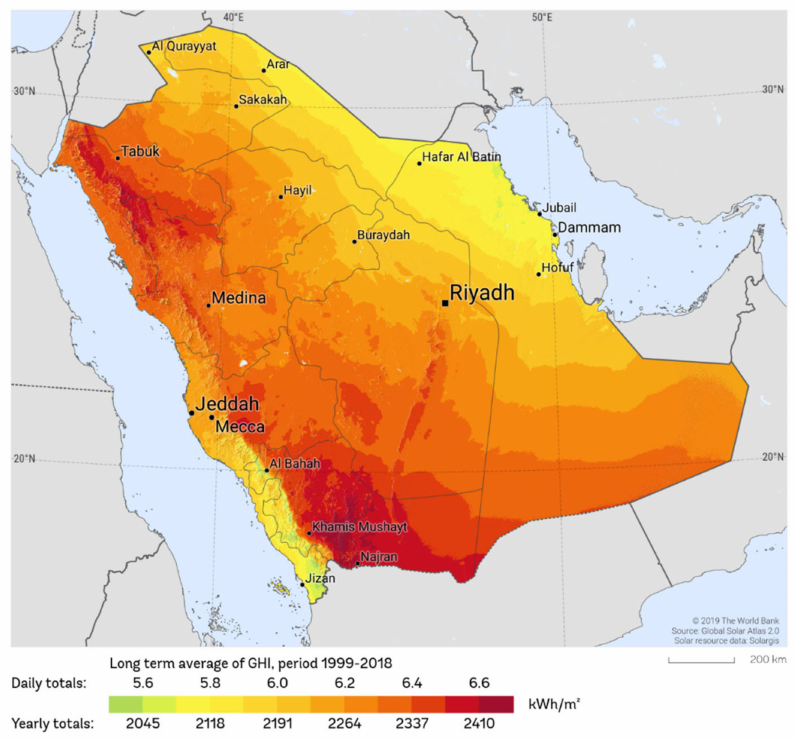
Figure 3. Global horizontal irradiation in Saudi Arabia